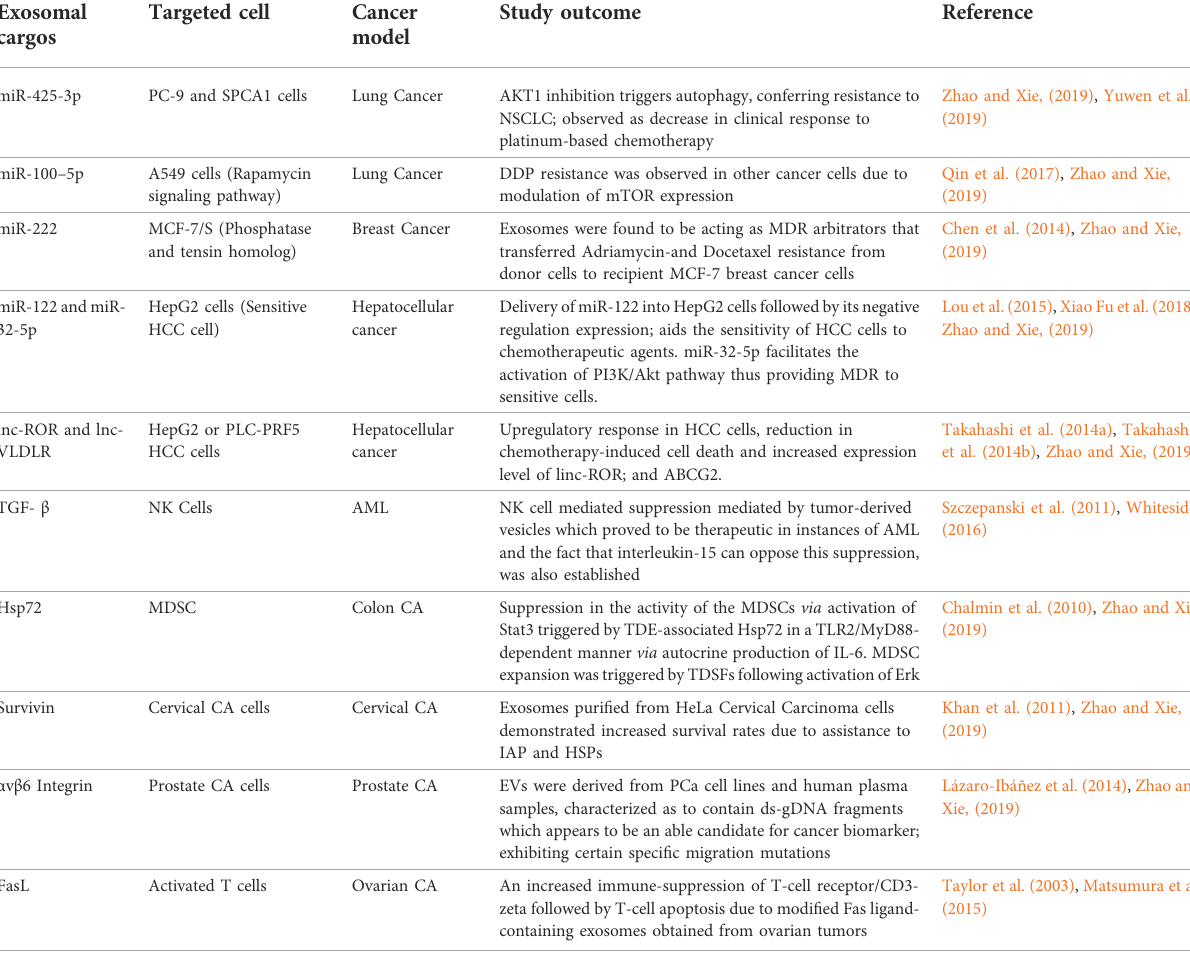
TABLE 3 An account of exosomal alterations manifested as therapeutic and restorative in speci fi c cancer